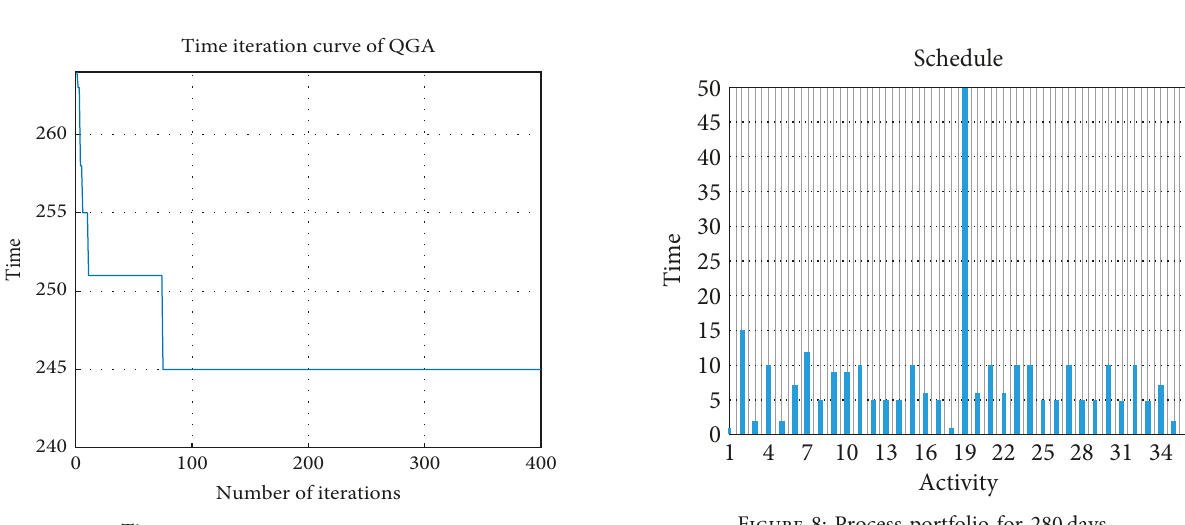
Figure 5: Iteration curve of the construction period in the mul- tiobjective quantum genetic algorithm.